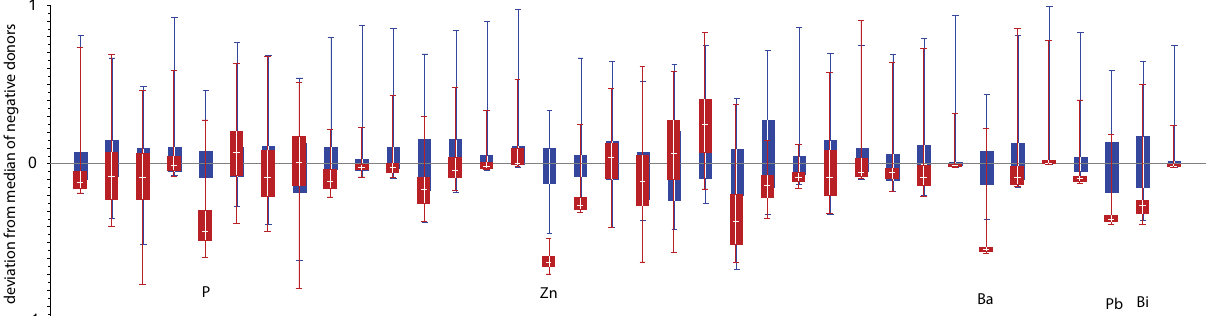
Figure 1. Variance in ICP-MS data between positive (red) and negative (blue) samples. A median mass spectrum of the negative samples has been subtracted from all spectra. All data was scaled to the 5–95 percentile range for each element. Error bars denote the interquartile